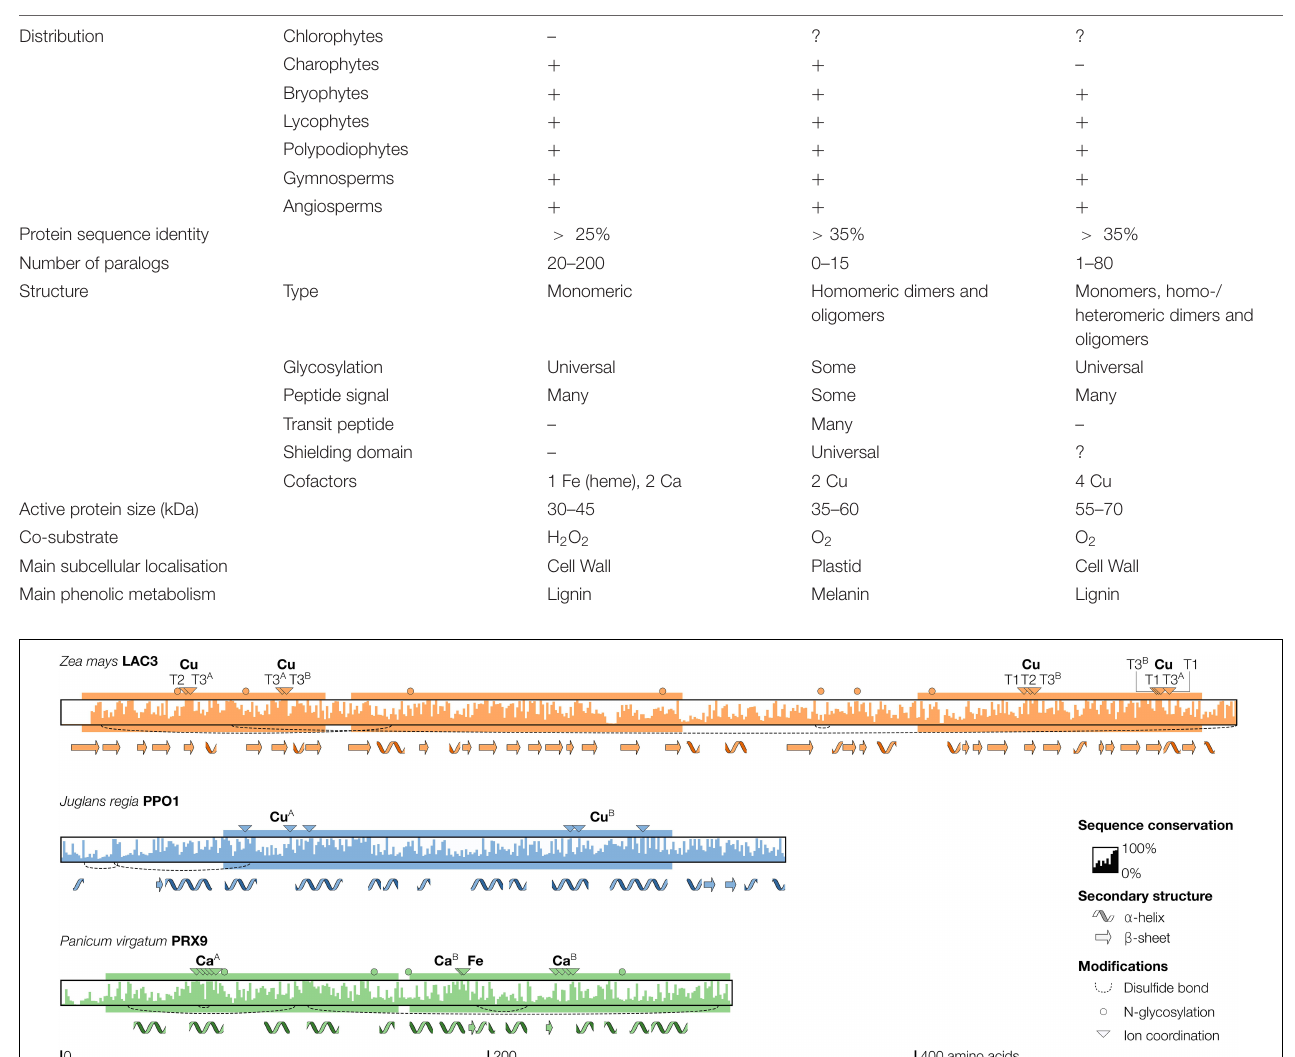
FIGURE 2 | Structural features and sequence conservation in mature protein chains of phenoloxidases. Conserved domains (plastocyanin, tyrosinase, and calcium-binding for LAC3, PPO1 , and PRX9 , respectively) are shown as solid rectangles. Secondary structures, positions of ion coordinating residues, N -glycosylation sites and disulfide bonds are indicated according to the respective published crystal structures. The bar coded sequence conservation is calculated across all paralogs from Populus trichocarpa, Brachypodium distachyon, Physcomitrium patens , and Selaginella moellendorffii . We have adopted the recent revision of the nomenclature of Physcomitrella patens to Physcomitrium patens (see Rensing et al.,